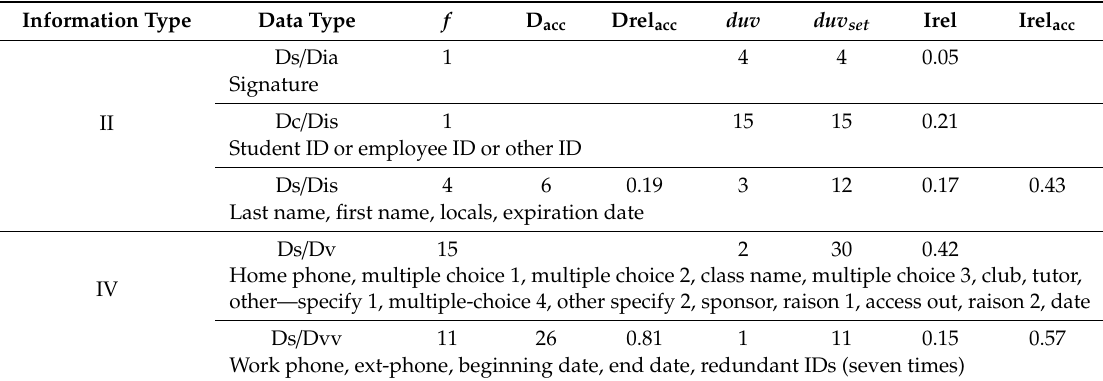
Table 3. Data classification and weighting. Frequency of accumulated data according information type zone (D acc ), relative frequency of accumulated data according information type zone (Drel acc ), information relative value (Irel), and accumulated information relative value (Irel acc ) for the F1–00